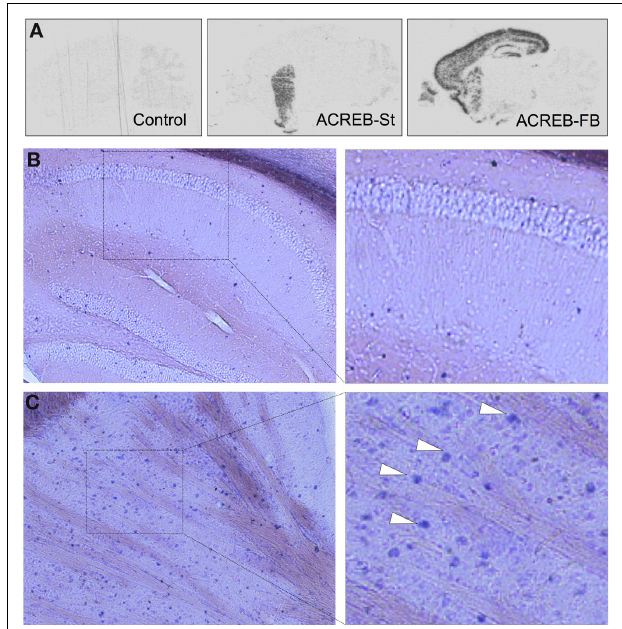
FIGURE 2 | Normal gross brain anatomy in ACREB-St mice. (A) Nissl staining of the coronal brain section of an adult ACREB-St mouse and a control littermate did not reveal gross anatomical changes (scale bar: 1 mm). (B) Immunostaining of brain sections showed Flag-M2 immunoreactivity in the dorsal striatum of ACREB-St mice (right), but not in their control littermates (left). Hippocampus, cortical layers and other brain regions did not show immunoreactivity (scale bar: 1 mm). (C) Immunostaining of coronal brain sections in an ACREB-St mouse showed positive cells (white arrows) both in the dorsal striatum (upper inset) and in the nucleus accumbens (lower inset). Scale bar: 0.5 mm. The same pattern of expression was observed in three mice per